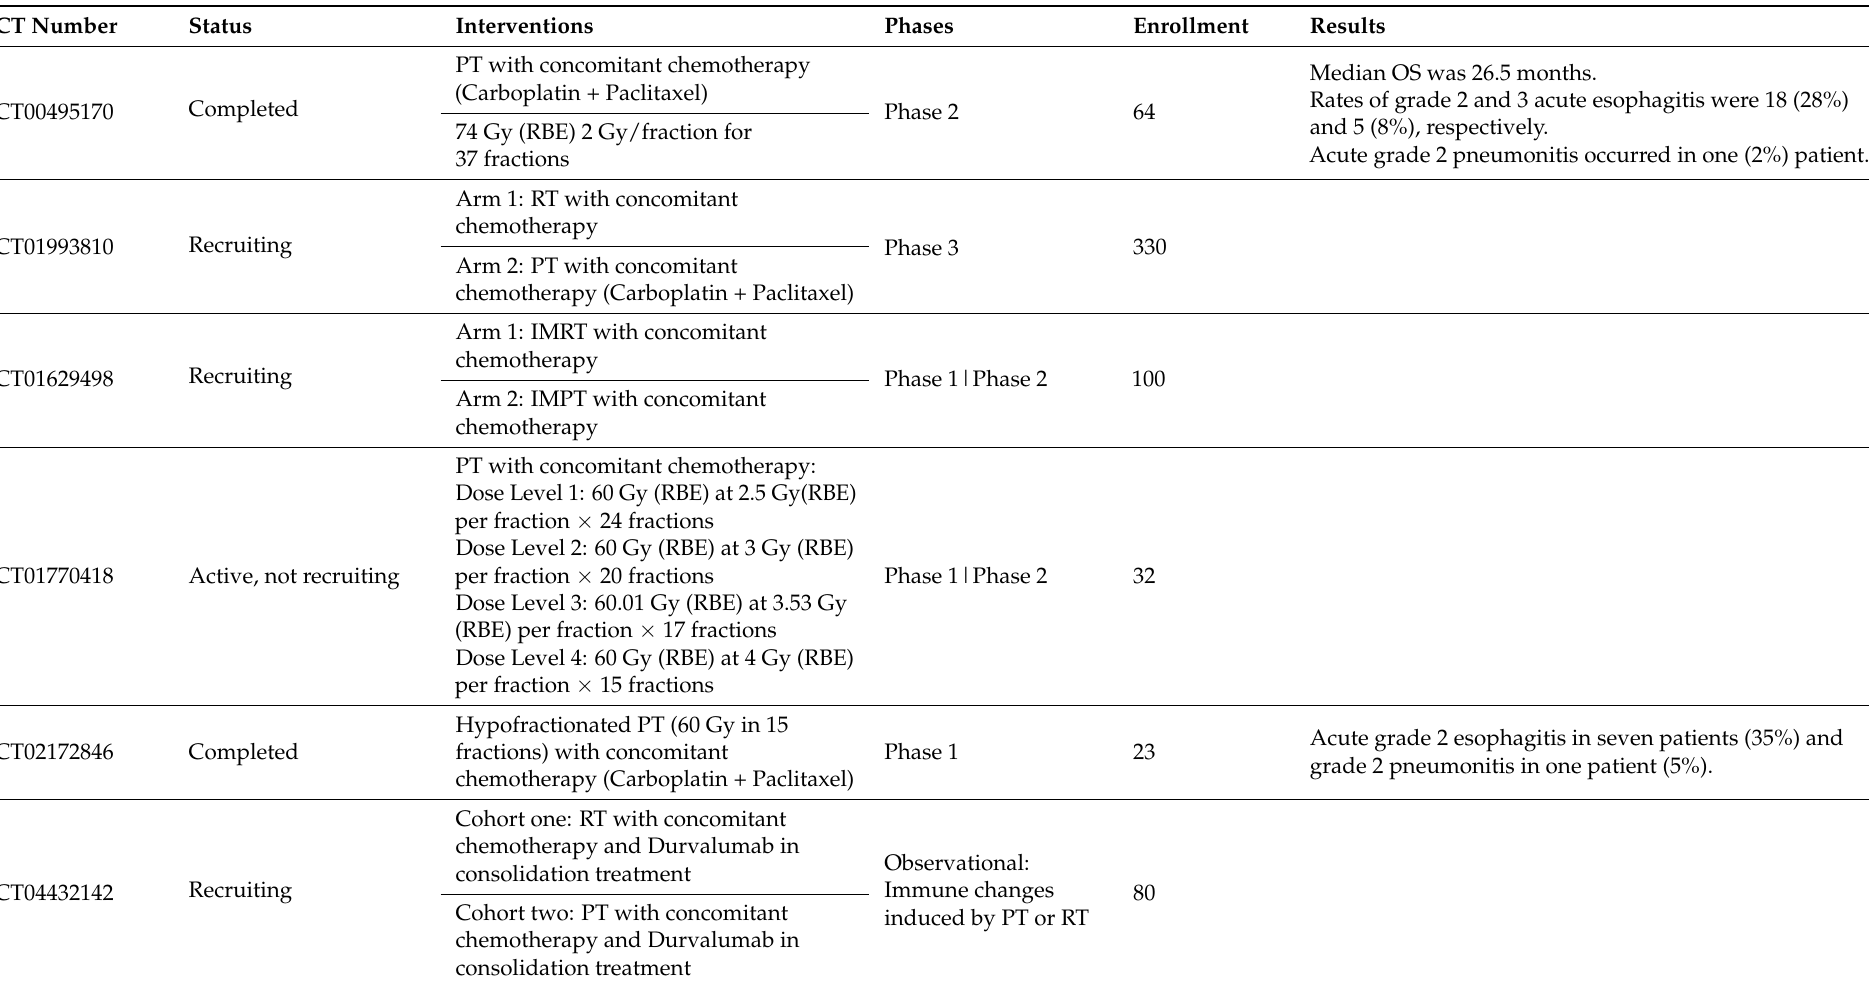
Table 2. Trials in unresectable stage III NSCLCs treated by